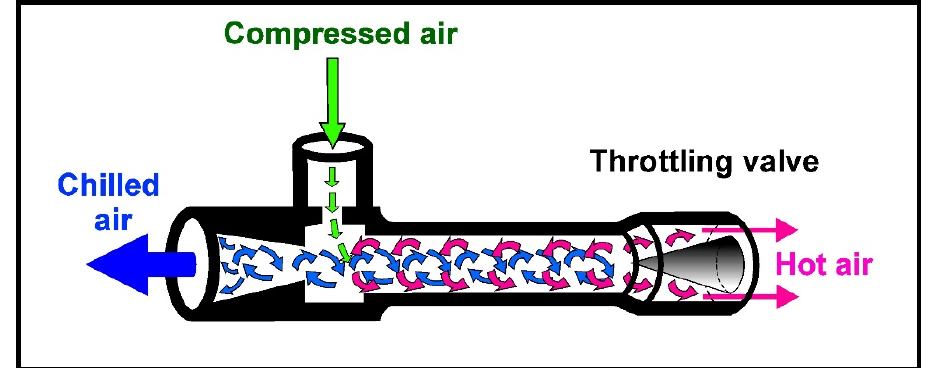
Figure 2. Jet cooling nozzle.